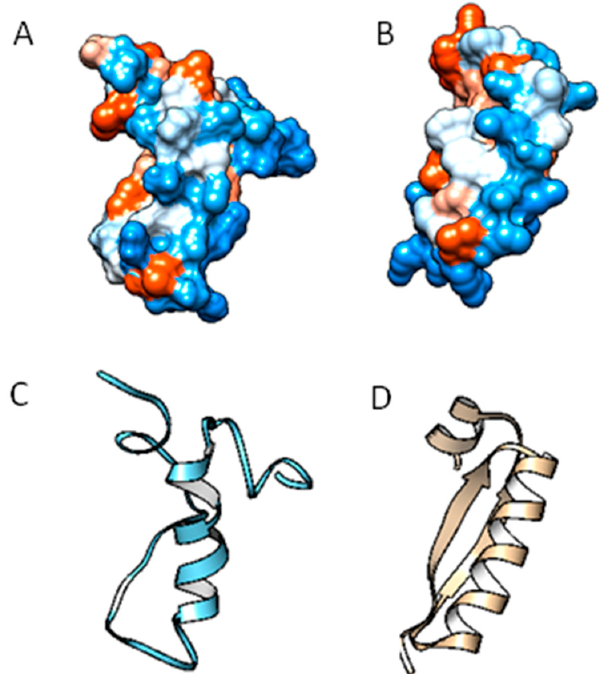
Figure 3. Tertiary model structure of human and bovine Lfcin. ( A ) Hydrophobicity model hLfcin domain (residues 17–41); PDB ID: 1BLF; and ( B ) bovine Lfcin (residues 17–31) modeled with 1bLf as